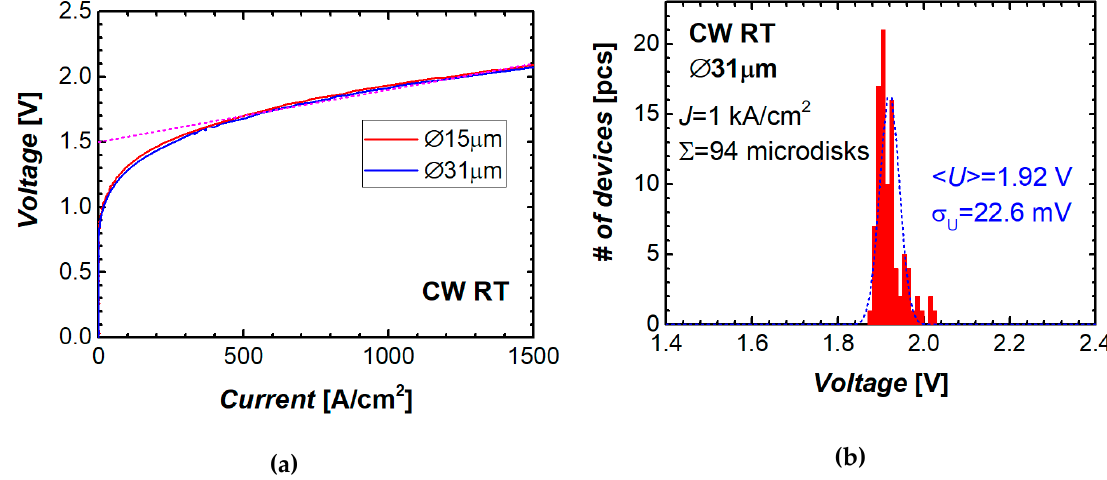
Figure 4. ( a ) Current–voltage curves of microdisk lasers of different diameters, dashed line represents the linear approximation; ( b ) bar diagram showing the distribution of diode voltage at constant current across 94 microdisks.